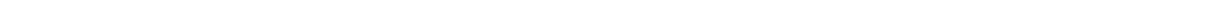
Figure 5 | Imaging of live cells after uptake of the DNAzyme motor system. ( a ) Images showing MDA-MB-231 cells after incubation with AuNPs functionalized with the substrate strand but not the DNAzyme strand (negative control). ( b ) Images showing MDA-MB-231 cells after incubation with the DNAzyme motor system but not subsequently treated with the cofactor Mn 2 þ (negative control). ( c ) Images showing the target MDA-MB-231 cancer cells after incubation with a mutant DNAzyme motor system and the subsequent treatment with the cofactor Mn 2 þ (negative control). ( d ) Images showing the target MDA-MB-231 cancer cells after incubation with the DNAzyme motor system and the subsequent treatment with the cofactor Mn 2 þ . Fluorescence images of the target cells are the result of intracellular operation of the DNAzyme motor. ( e ) Images showing the negative control MCF-10a cells after the same treatment as for the MDA-MB-231 cells in d . ( f ) Images showing the negative control MCF-7 cells after the same treatment as for the MDA-MB-231 cells in d . All images were collected at the end of 60min operation time (i.e., 60min after the addition of the cofactor Mn 2 þ ). Fluorescence imaging of living cells was performed using an Olympus IX-81 microscope equipped with a Yokagawa CSU (cid:3) 1 spinning disk confocal scan-head and a Hamamatsu EMCCD camera with (cid:3) 40/1.3 Oil and (cid:3) 20/0.85 Oil objective lenses. A pumped diode laser at 491nm was used for the excitation of FAM. Magnification was chosen to allow a final pixel size of 447nm with (cid:3) 20 lens and 223nm with (cid:3) 40 lens. The length of the scale bar is 17 m